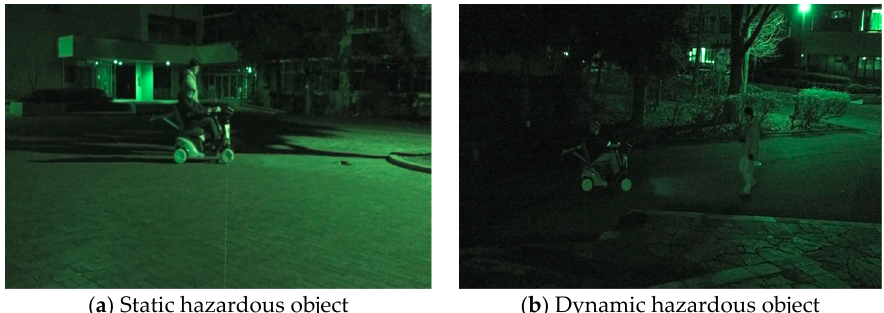
Figure 10. Installation of Camera A.